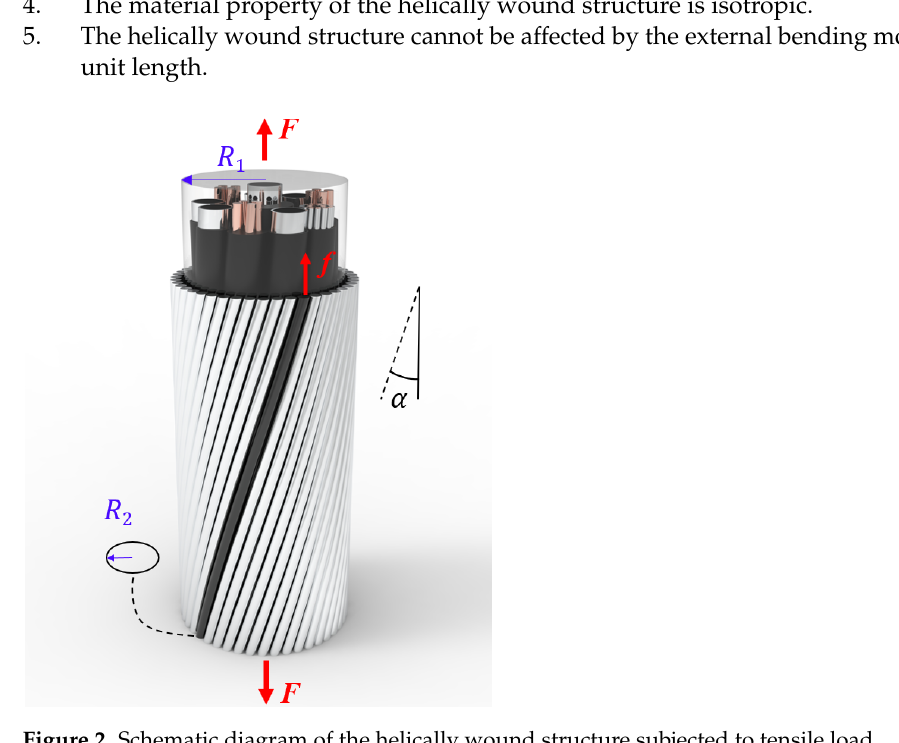
Figure 2. Schematic diagram of the helically wound structure subjected to tensile load.